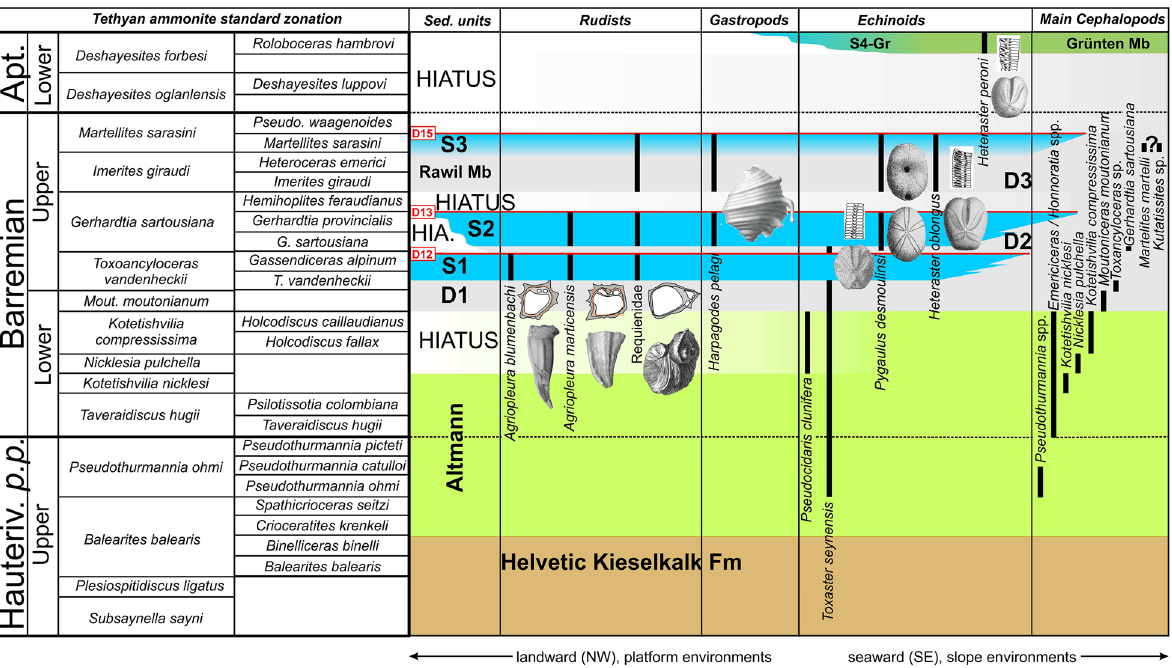
Fig. 16 Time–space diagram of the upper Hauterivian to lower Aptian sedimentary succession in the Alpstein massif. The proximal settings of the Schrattenkalk platform are situated on the left and the slope deposits of the Tierwis Formation are on the right. S1–S3 Formation, D1–D3 units of the Drusberg Member of the Tierwis Formation Standard Mediterranean ammonite zonation modified after Reboulet = et al. (2018). Rudist-shells drawings from Matheron (1842) and from Pictet and Campiche (1868–1871). Rudist-cross sections modified after Masse and Fernerci-Masse (2015). Harpagodes drawing from Pictet and Renevier (1854–1858). Echinoids drawings from Pictet and Renevier (1858), de Loriol (1873) and Lambert (1920). Ambulacral pores drawings from Clavel in Charollais et al. (2009) and from Clavel et al.